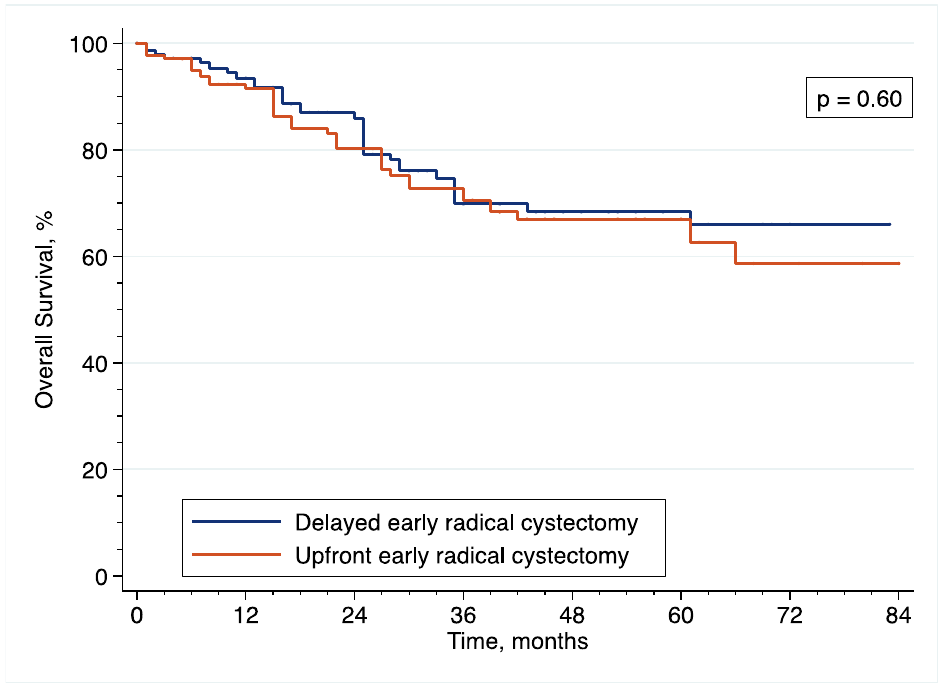
Figure 8. Inverse probability of treatment weighting (IPTW)-adjusted Kaplan–Meier curves that compare the OS of included patients treated with upfront or delayed eRC for HR-NMIBC.